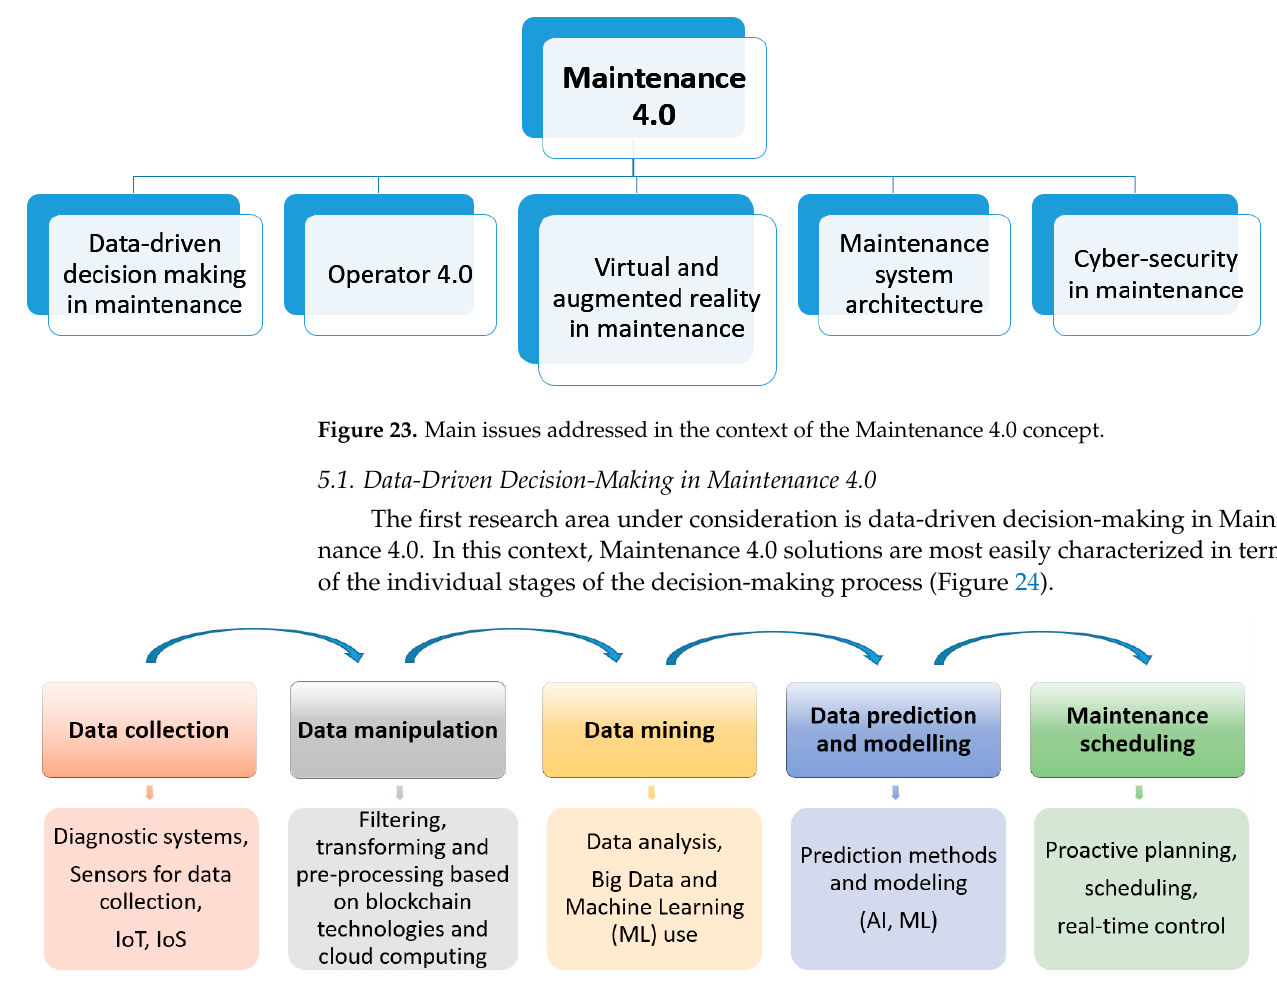
Figure 24. Data-driven decision-making in maintenance. Source: own contribution based on [17].